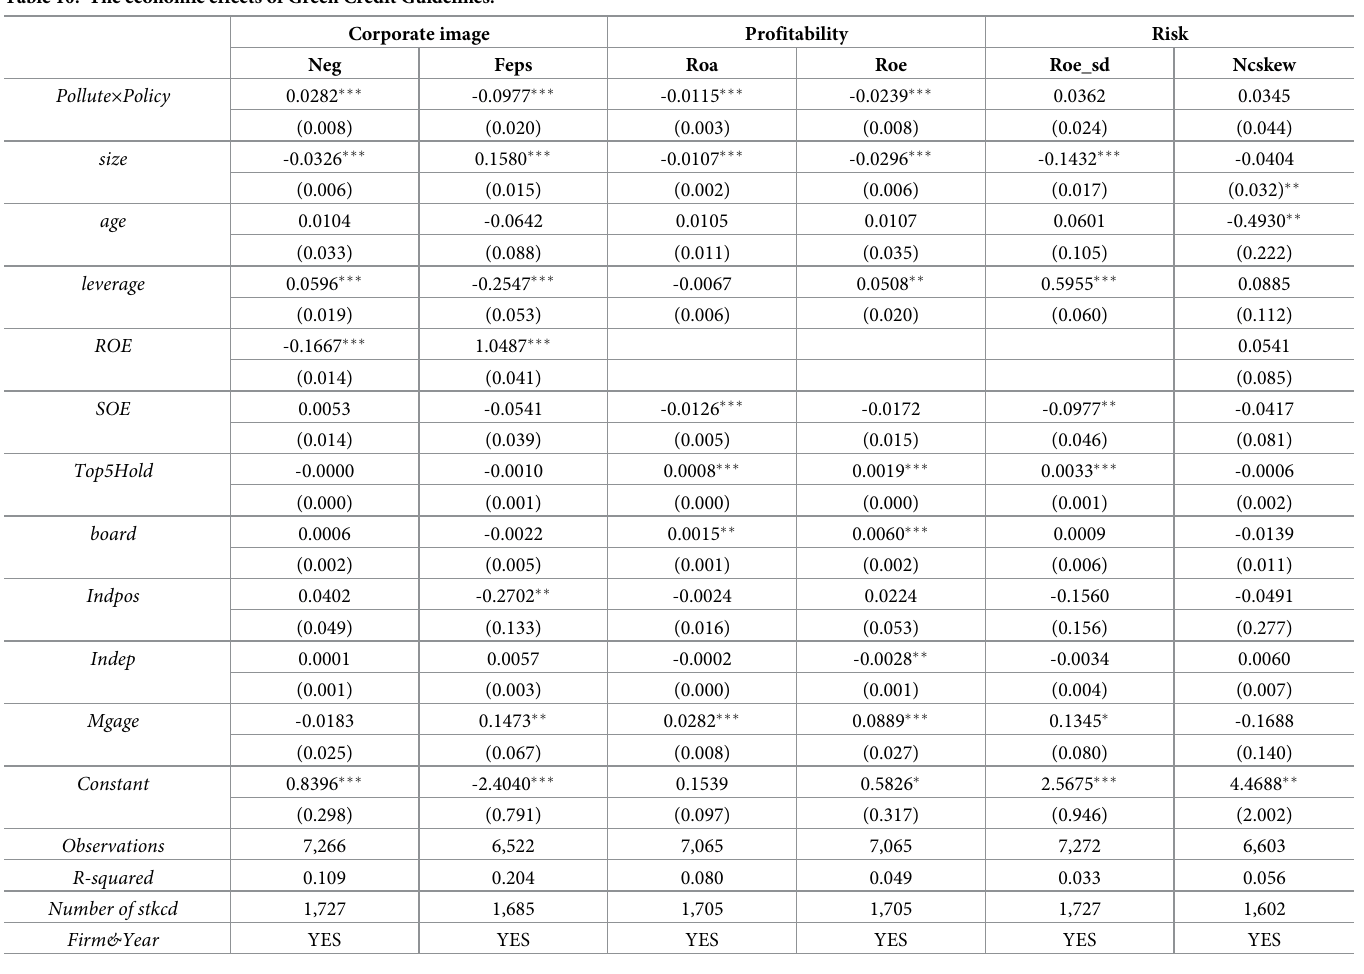
Table 10. The economic effects of Green Credit